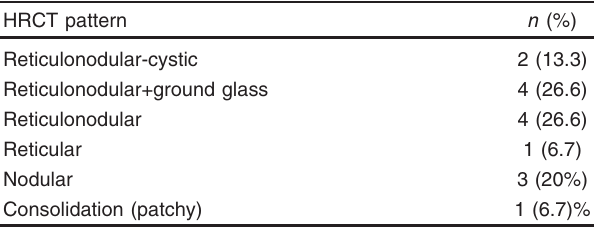
Table 2 High-resolution computed tomography pattern in the study sample